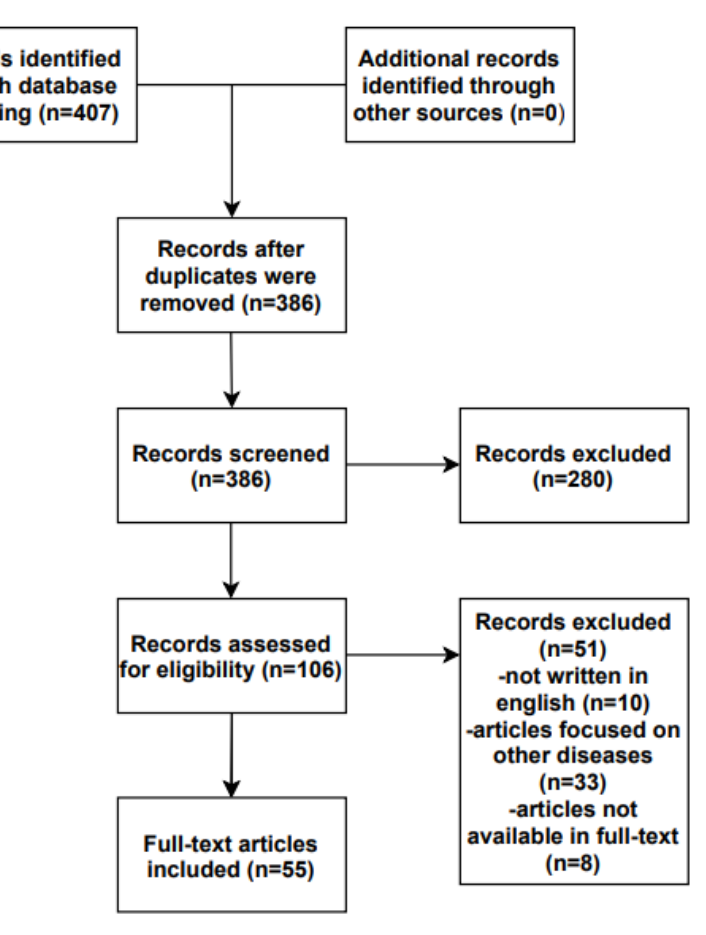
Figure 1. Flow Figure 1. Flow diagram.